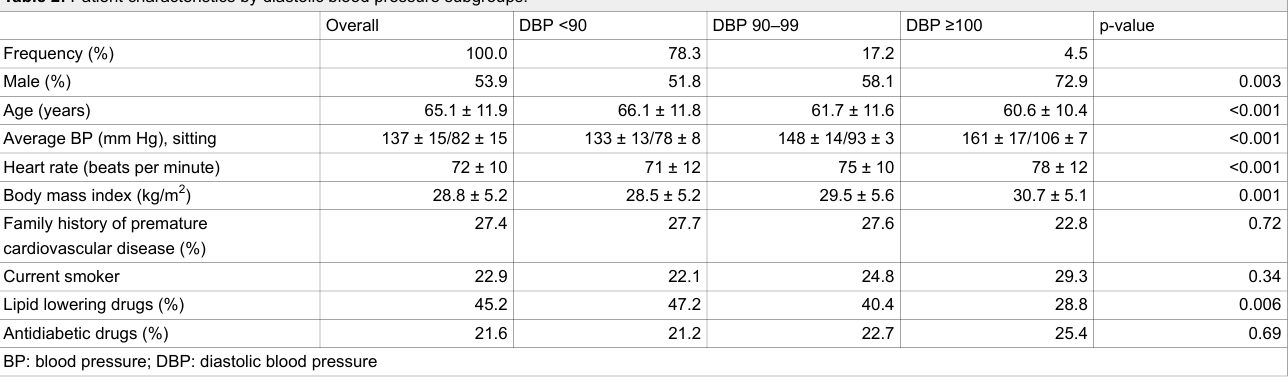
Table 2: Patient characteristics by diastolic blood pressure subgroups.